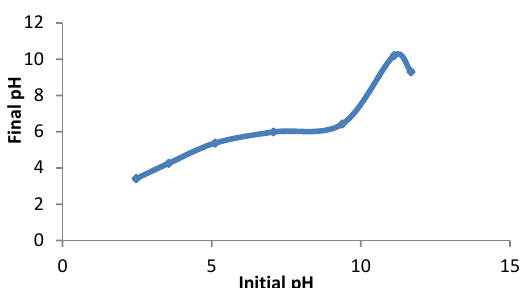
Fig.4b. Point of zero charge of the prepared activated carbon